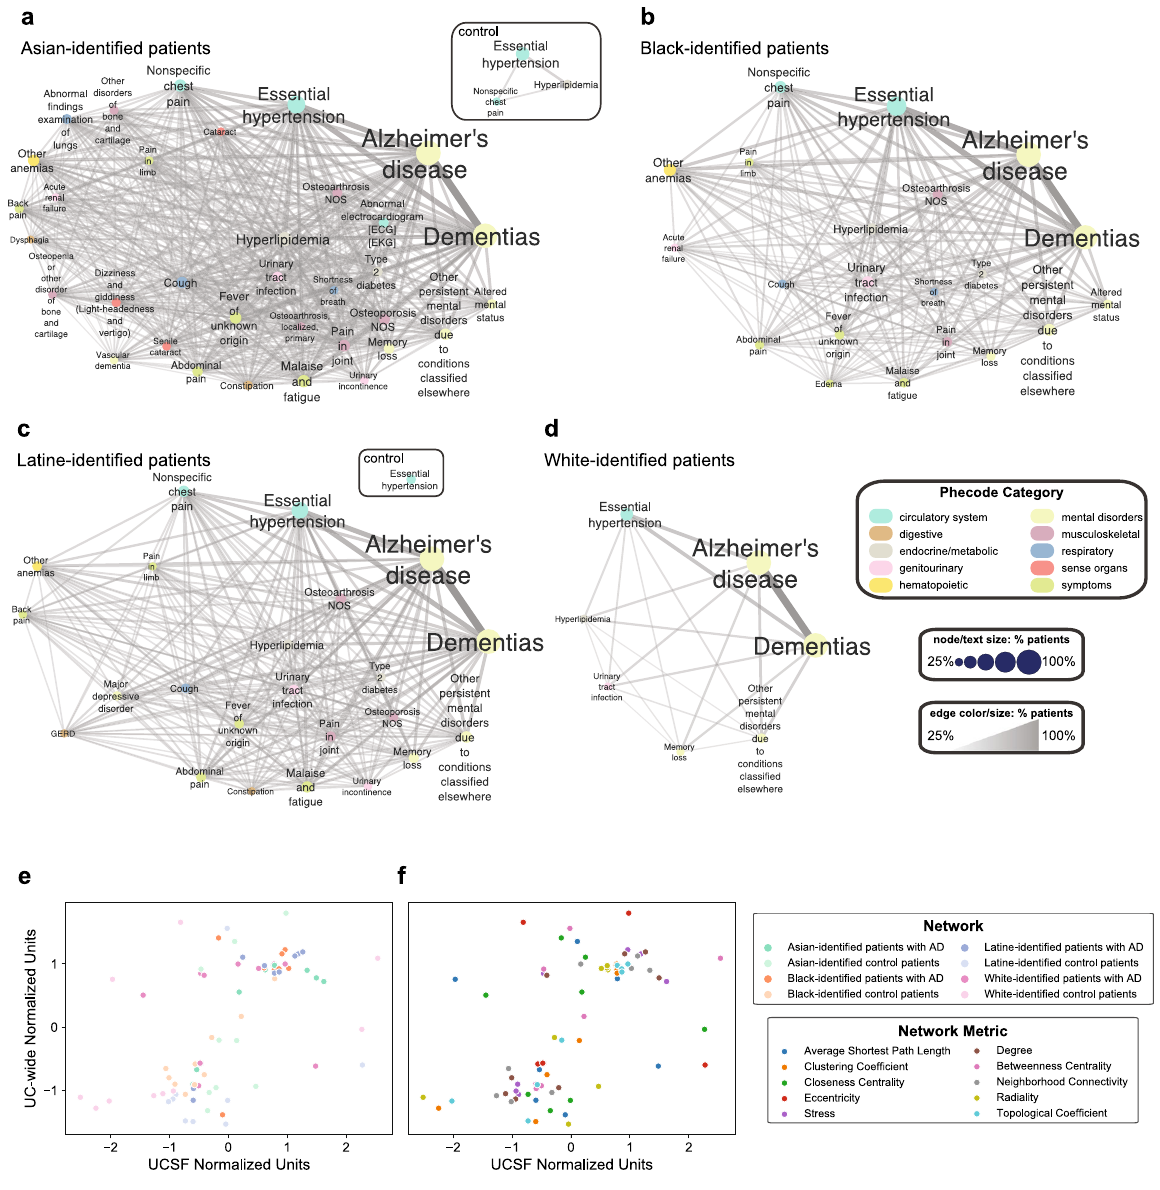
Fig. 6 Phenotype network visualization of patients, strati fi ed by identi fi ed R&E. Phenotype networks for ( a ) Asian-, ( b ) Black-, ( c ) Latine-, and ( d ) White- identi fi ed patients with AD ( n = 422 patients per identi fi ed R&E category) who received care at UCSF are thresholded by 25% of shared phenotypes for visualization. When applicable, phenotype networks of UCSF-based control patients strati fi ed by identi fi ed R&E, thresholded by 25% of shared phenotypes for visualization, are also shown ( n = 844 patients per identi fi ed R&E category). e , f Correlation plot of z-score normalized network metrics between UCSF and UC-wide, with colors representing network ( e ) or network metric ( f ) (two-sided Spearman ’ s ρ = 0.64, p -value = 2.1e − 10). For panels a – d , phecode categories are colored as follows: teal = circulatory system; brown = digestive system; gray = endocrine/metabolic; pink = genitourinary; yellow = hematopoietic; light green = mental disorders; purple = musculoskeletal; blue = respiratory; red = sense organs; green = symptoms. Node and text size correspond to percentages of patients with a given phenotype ranging from 25 to 100%. Edge color and size correspond to percentages of patients sharing a phenotype pair, ranging from 25 to 100%. At UCSF, at least 5% of Asian-identi fi ed patients with AD shared 270 nodes, while at least 5% of Asian-identi fi ed control patients shared 111 nodes ( a ). At least 5% of Black-identi fi ed patients with AD shared 234 nodes, while at least 5% of Black-identi fi ed control patients shared 30 nodes ( b ). At least 5% of Latine-identi fi ed patients with AD shared 244 nodes, while at least 5% of Latine-identi fi ed control patients shared 42 nodes ( c ). At least 5% of White-identi fi ed patients with AD shared 142 nodes, while at least 5% of White- identi fi ed control patients shared 9 nodes ( d ). For panel e , green = Asian-identi fi ed patients with AD; light green = Asian-identi fi ed control patients; orange = Black-identi fi ed patients with AD; light orange = Black-identi fi ed control patients; purple = Latine-identi fi ed patients with AD; light purple = Latine-identi fi ed control patients; pink = White-identi fi ed patients with AD; light pink = White-identi fi ed control patients. For each of the 8 networks represented, 10 network metrics were compared between UCSF and UC-wide validation cohort. For panel f , blue = Average Shortest Path Length; orange = Clustering Coef fi cient; green = Closeness Centrality; red = Eccentricity; purple = Stress; brown = Degree; pink = Betweenness Centrality; gray = Neighborhood Connectivity; light green = Radiality; cyan = Topological Coef fi cient. For each of the 10 network metrics represented, 8 networks were compared between UCSF and UC-wide validation cohort. AD Alzheimer ’ s dementia, UCSF University of California San Francisco.